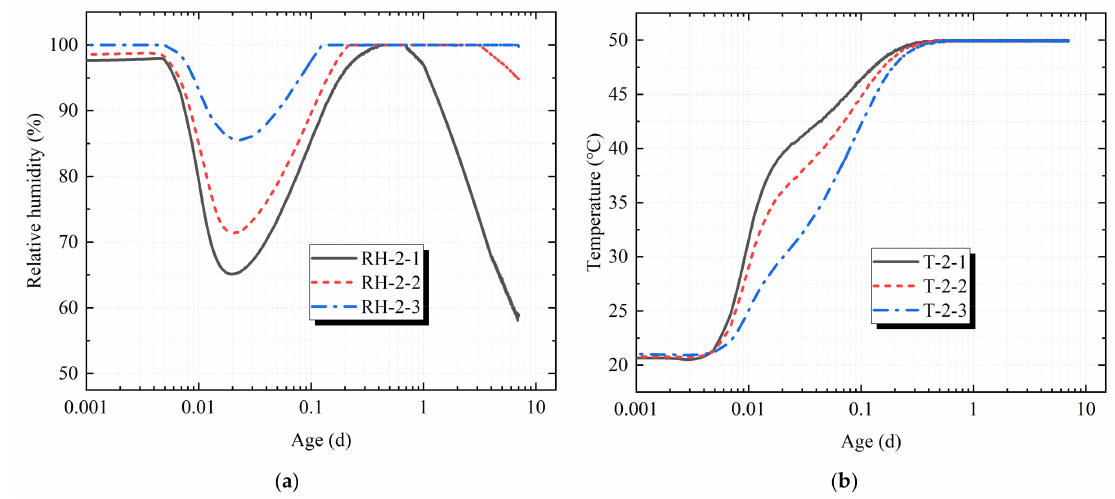
Figure 6. Duration curve of non-restrained specimen. ( a ) Duration curve of temperature; ( b ) duration curve of relative humidity. The relative humidity in the test chamber was set at 30%. The relative